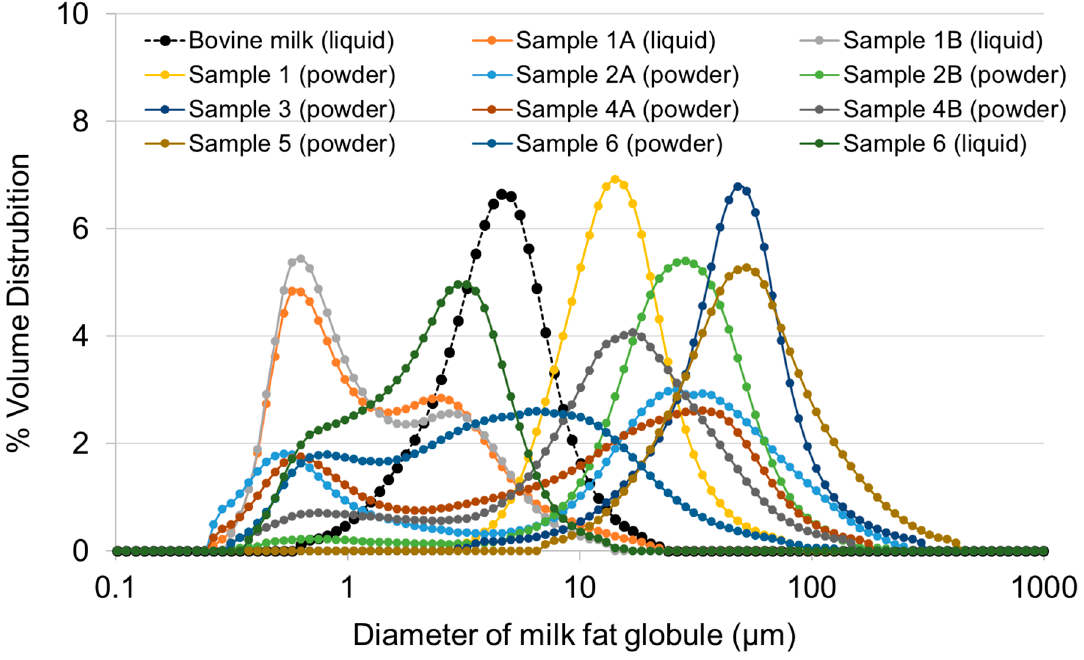
Figure 7. Size distribution of all liquid and powder WPPC samples from the data set and comparison with fresh raw bovine milk.